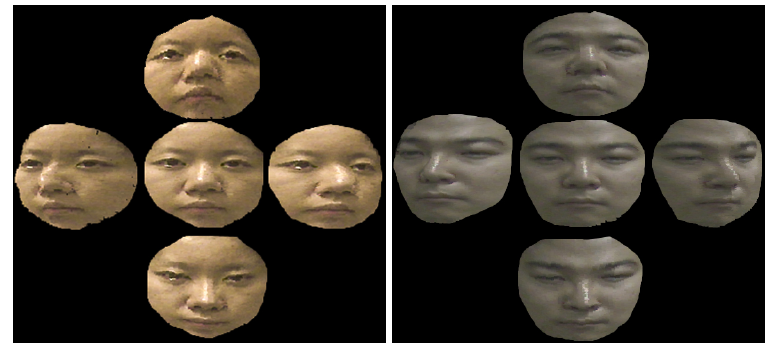
Figure 16. Reconstructed 3D face data.